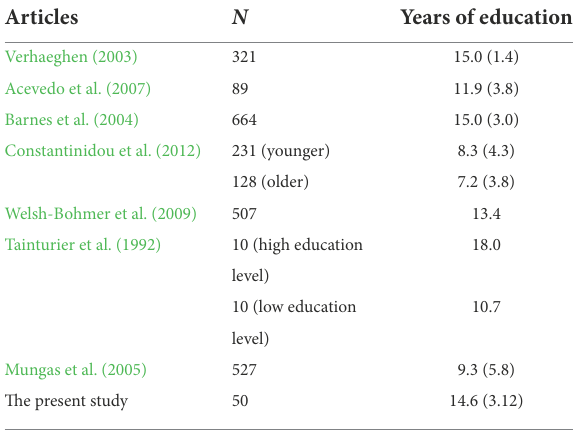
TABLE 5 Descriptive statistics of length of education in previous